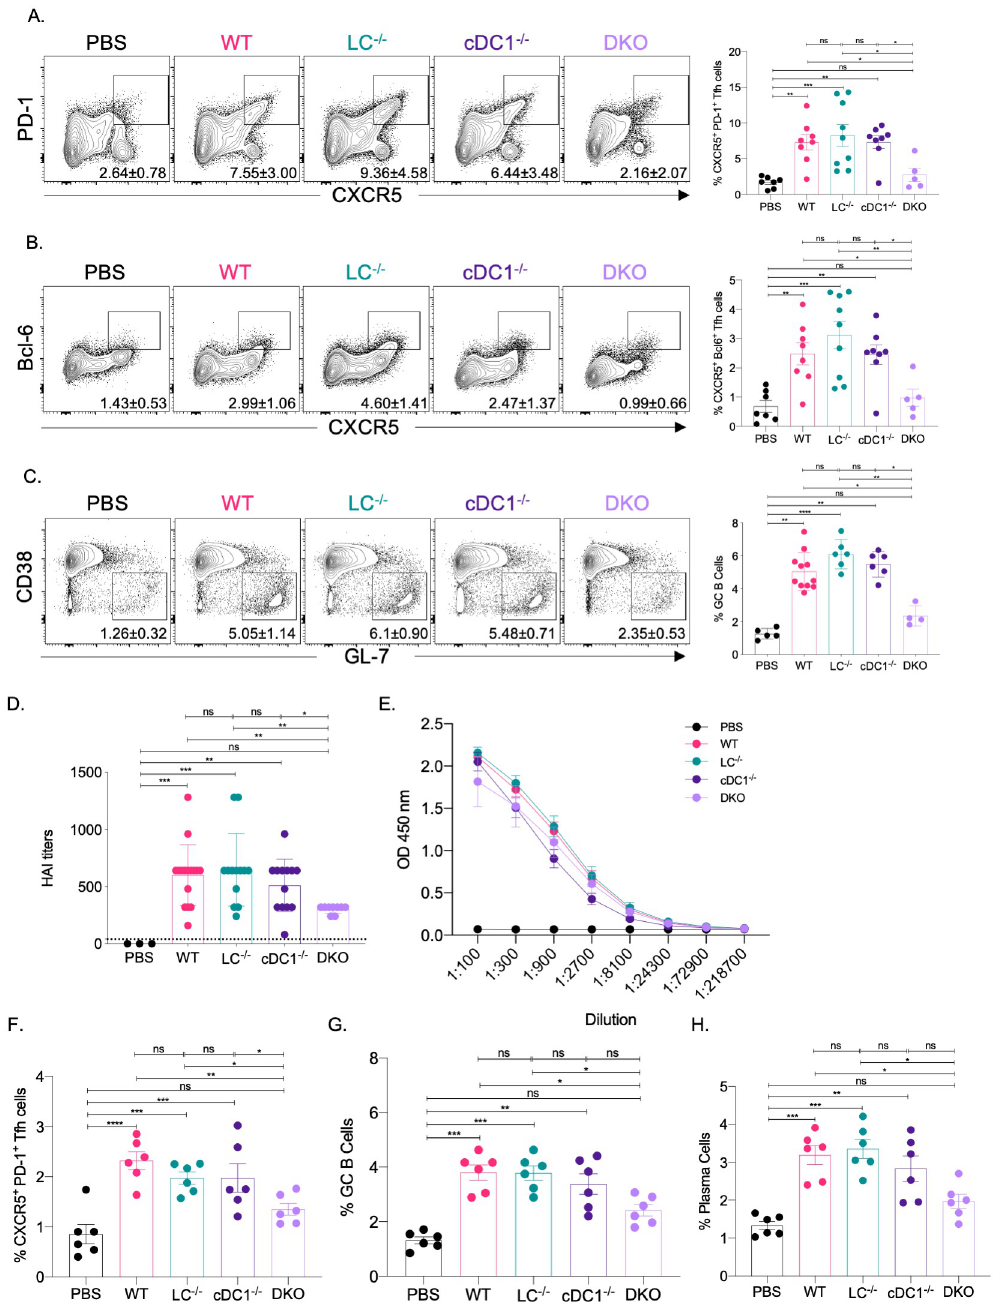
Fig 1. LCs and cDC1s play redundant roles in anti-flu and SARS-CoV-2 adaptive immune responses triggered by the mRNA-LNP platform. A . and B . The indicated mice were injected with 10 μ g of mRNA-LNP coding for PR8 HA and the Tfh cell responses assessed in the skin draining lymph nodes 7 days post immunization. Mice injected with PBS served as control for basal levels. On the left representative flow plots while on the right summary graphs are presented. C . As in A , except that the lymph nodes were harvested 14 days post immunization and the GC responses determined using flow cytometry. On the summary graphs the % of Tfh cells refers to CD4 + T cells in the CD44/CD62L gate, while the % of GC B cells refers to B cells in the B220/CD138 gate (S1 Fig). D . and E . Serum samples from mice euthanized 14 days post immunization were assessed using HAI and ELISA. F . through H ., as in A and C , except that the samples for Tfh cell responses were also harvested 14 days post-immunization with mRNA-LNP coding for SARS-CoV-2 RBD. Data were pooled from 2–3 independent experiments. Each dot represents a separate animal.